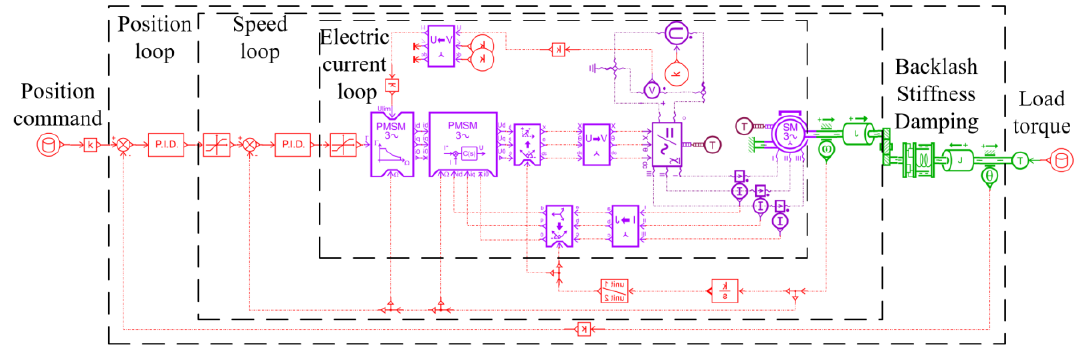
Figure 17. System simulation model of GIERM.